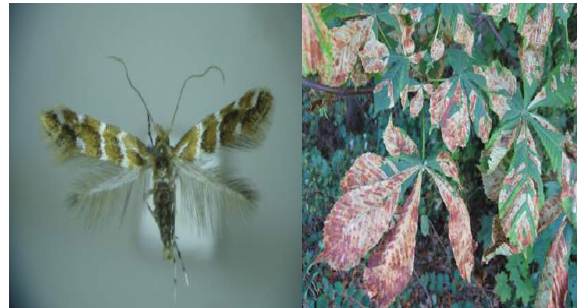
Fig. 4. Cameraria ohridella Deschka & Dimic and the results of infesting the leaves of Aesculus hippocastanum